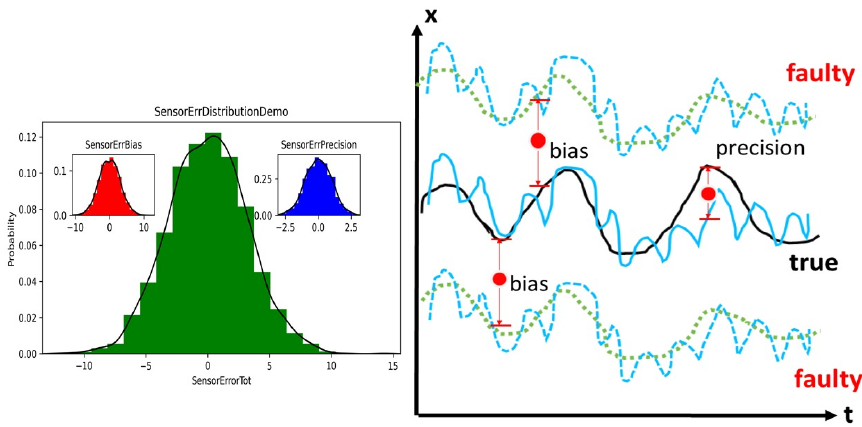
Figure 4. Sensor error diagram.